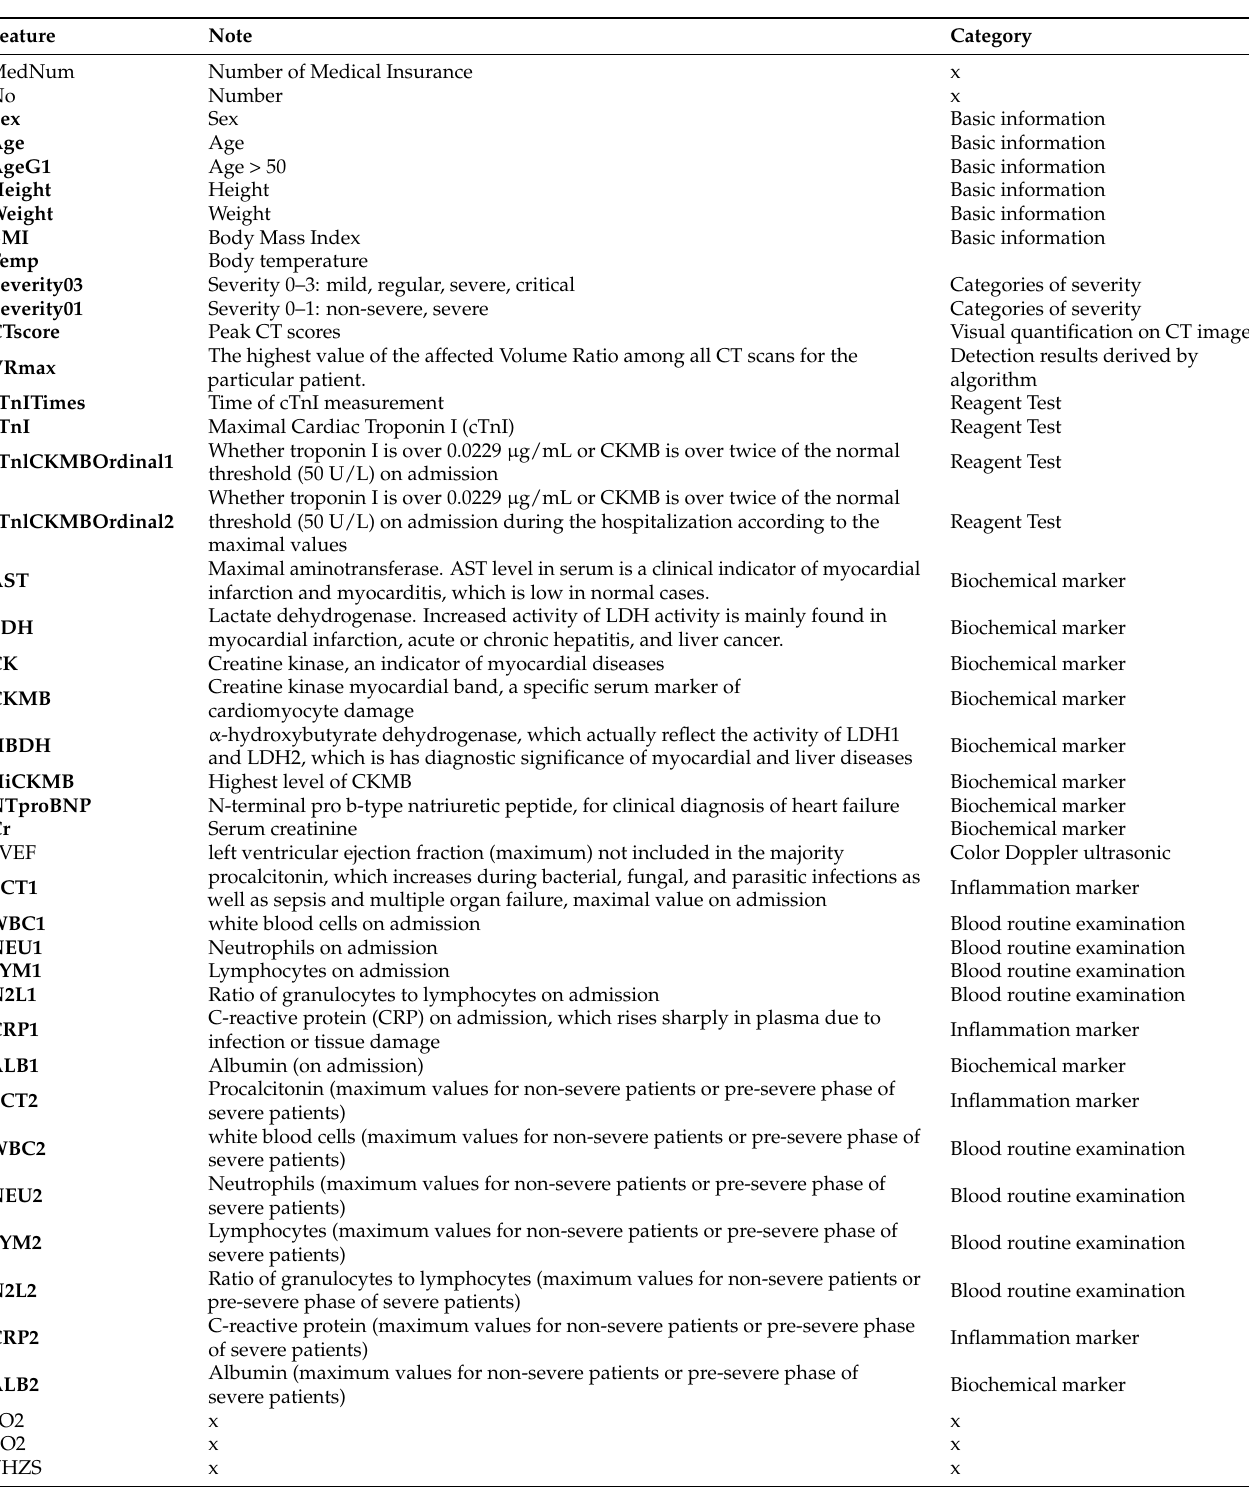
Table A1. Clinico-radiological